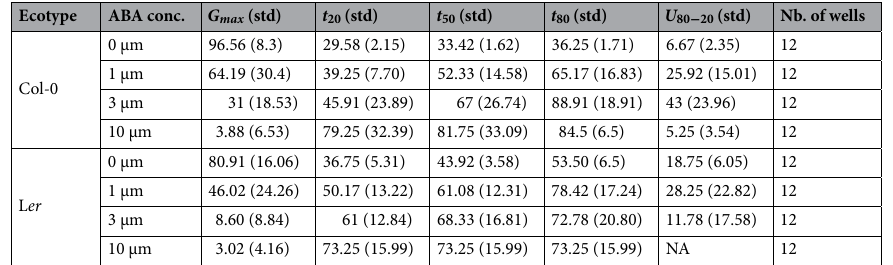
Table 3. Comparison of average physiological indices regarding ABA dose response for germination inhibition of L er and Col-0 accessions. In brackets are the standard deviations of the means. In stressed condition, only wells with more than 2 germinated seeds were used to compute the averages of t 20 , t 50 , t 80 and U 80 − 20 respectively. Treatments have been randomized (c.f. Supplementary Data S5 online). The experiment has been done from a single microplate in order to illustrate that expected effect of ABA can be detected from a single microplate. If one would like to draw conclusions regarding the impact of ABA on germination, multiple independent analyses would be